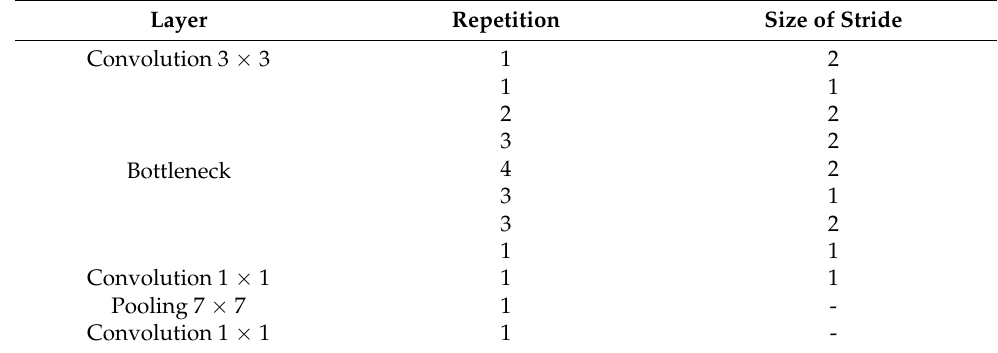
Table 2. The internal architecture of